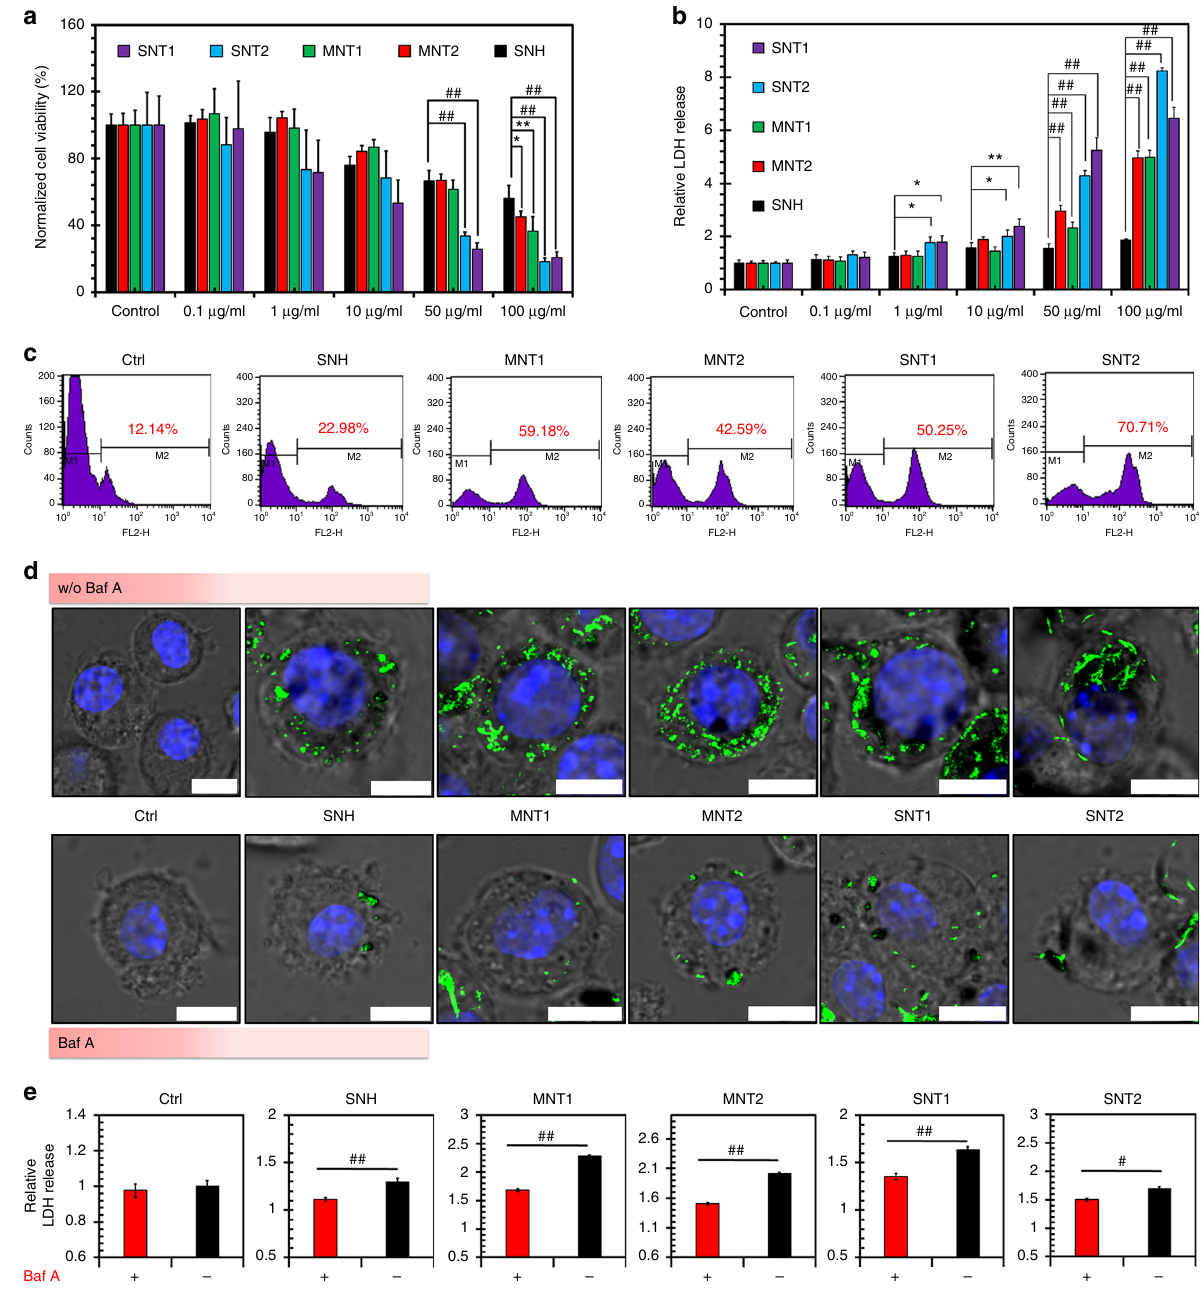
Fig. 2 SNH caused lower nanotoxicity than CNT. a , b Cellular viability comparisons of different nanocarbons detected by a MTT assay and b LDH release investigations ( n = 5). c Flow cytometry analysis of nanocarbon-incubated cells via PI labeling assay. d Confocal images of cells after nanocarbon incubations with and without Baf A addition. Intracellular nanocarbons were detected by laser re fl ection (LR) technology and shown with pseudo green color. Scale bar: 10 μ m. e Cytotoxic analysis of different nanocarbons based on LDH release assay with and without Baf A addition (n = 4). In a , b , and e , data were presented as means ± s.d. Statistical signi fi cances were calculated by Student ’ s t -test: * p < 0.05, ** p < 0.01, # p < 0.005, ## p < was fi rstly investigated. Poly-ADP-ribose polymerase (PARP) MTT and LDH assays had the same fi ndings (Supplementary cleavage and caspase-3 (CASP-3) activation, two hallmarks of Fig. 26c and d), even if the macrophage uptake of SNH was apoptosis, were analyzed by western blot (WB). As illustrated in identical with four types of CNT. So it was concluded that the low Fig. 3a, b, CNT triggered obvious cleavages of PARP and CASP-3 cytotoxicity of SNH was closely associated with its morphological compared to control and SNH group, and in more detail, CNT structure. triggered 2.1 – 3.4 folds of PARP and 2.8 – 4.0 folds of CASP-3 compared to SNH group (Fig. 3c, d). The signi fi cant increases of cleavage ratios in CNT groups con fi rmed the apoptosis mechanism. Caspase-8 (CASP-8) and caspase-9 (CASP-9), as the upstream regulative proteins, were further analyzed (Fig. 3e). It